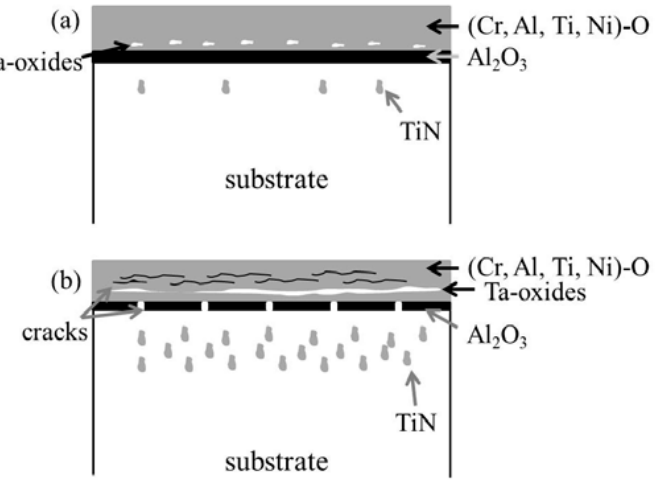
Figure 14. Schematic diagrams of the oxidation mechanisms of the alloys: ( a ) alloys with Ta/Cr ≤ 0.5; ( b ) alloys with Ta/Cr > 0.5.